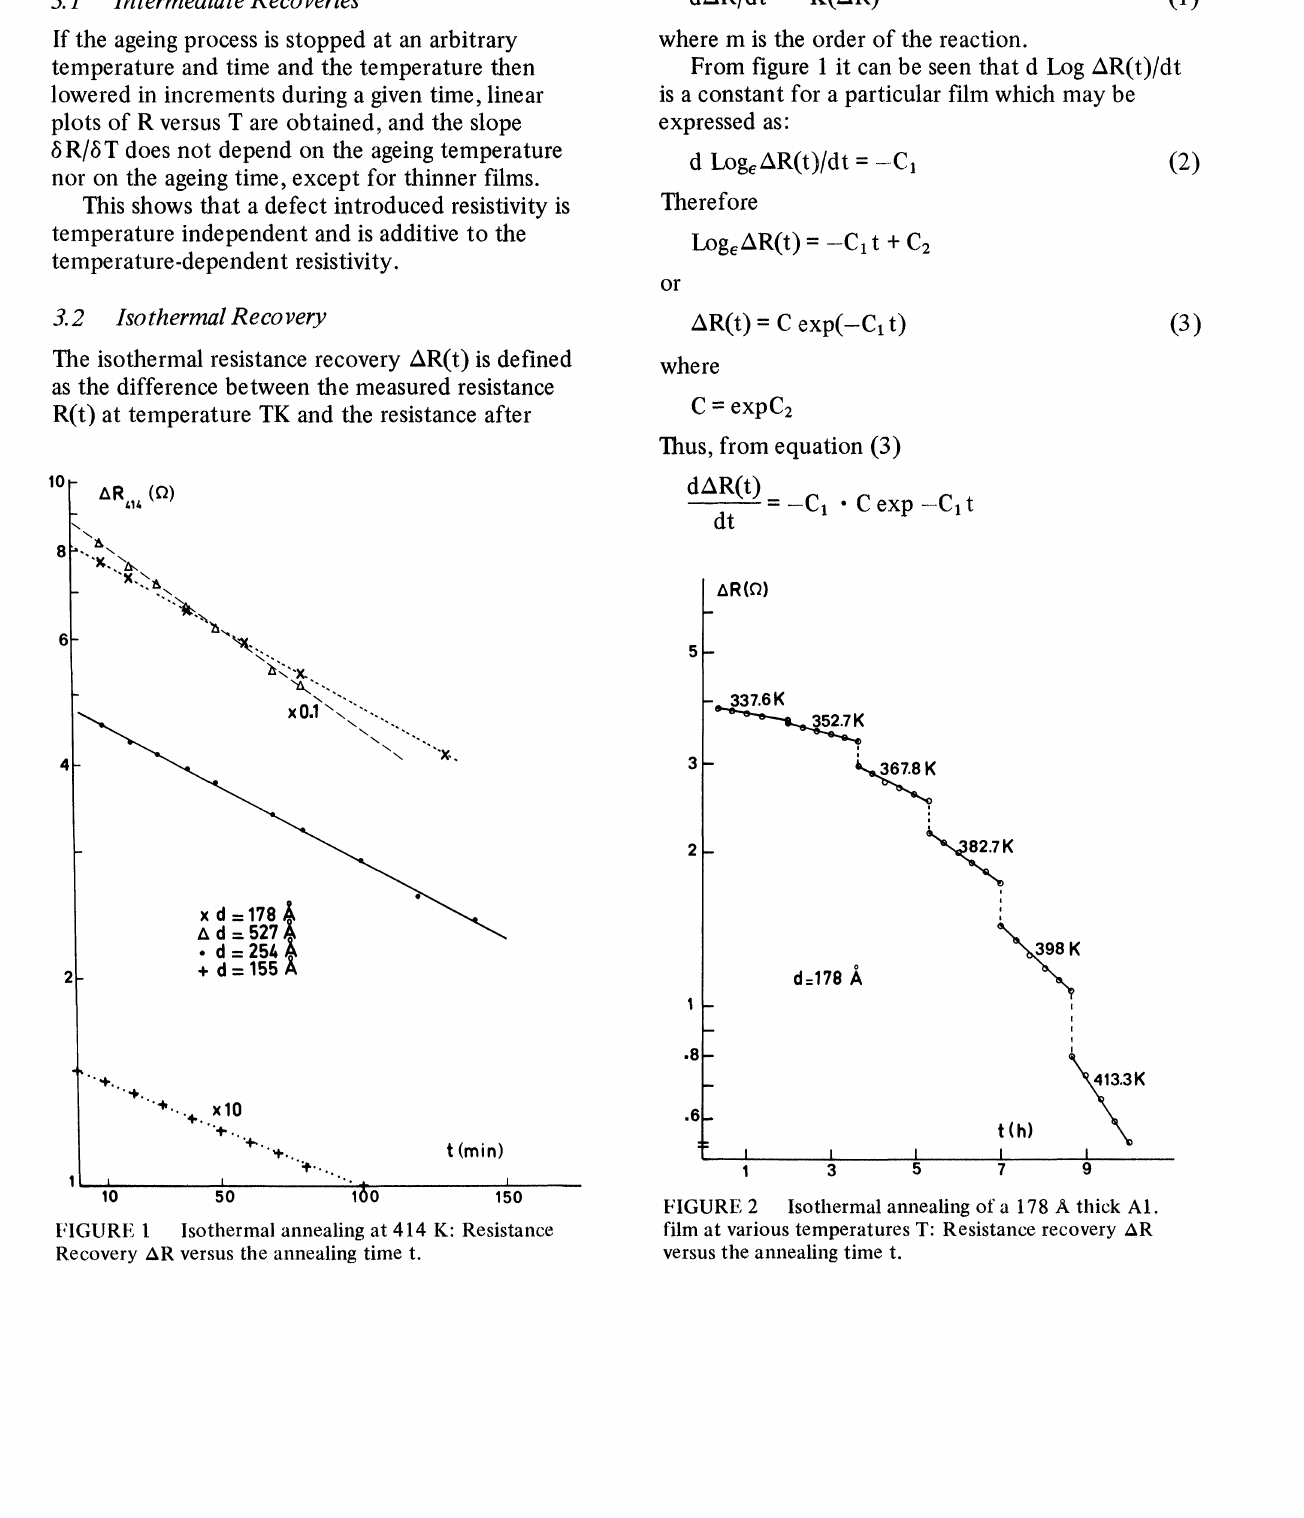
Isothermal annealing at 414 K: Resistance Recovery AR versus the annealing time t.